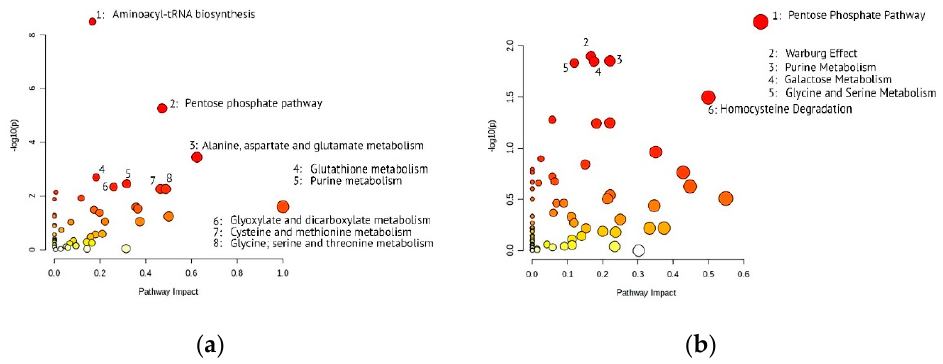
Figure 2. Results of pathway analysis via MetaboAnalyst against ( a ) KEGG and ( b ) SMPDB datasets in terms of p -value and pathway impact. Each cycle represents a pathway; its color denotes the significance level (from low—pale yellow to high—red). Most significant pathways ( p -value < 0.01 and <0.05 for KEGG and SMPDB, correspondingly) are additionally indicated.